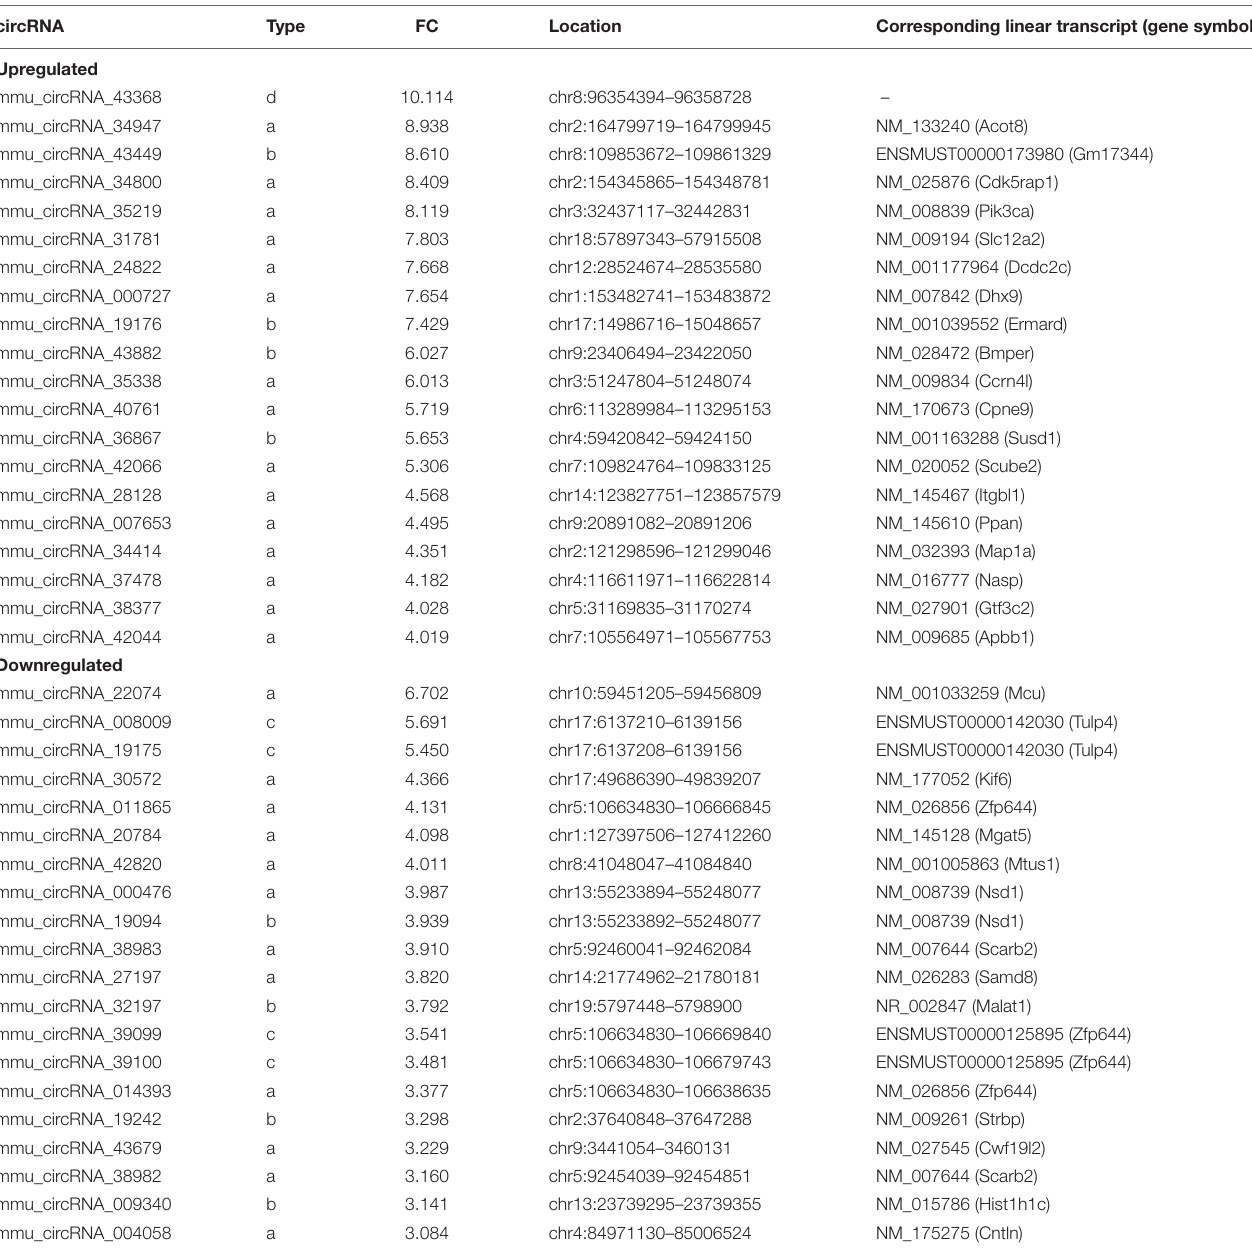
TABLE 5 | Top 40 significantly dysregulated circRNAs in 8W-post-TAC mouse heart. circRNA Type FC Location Corresponding linear transcript (gene